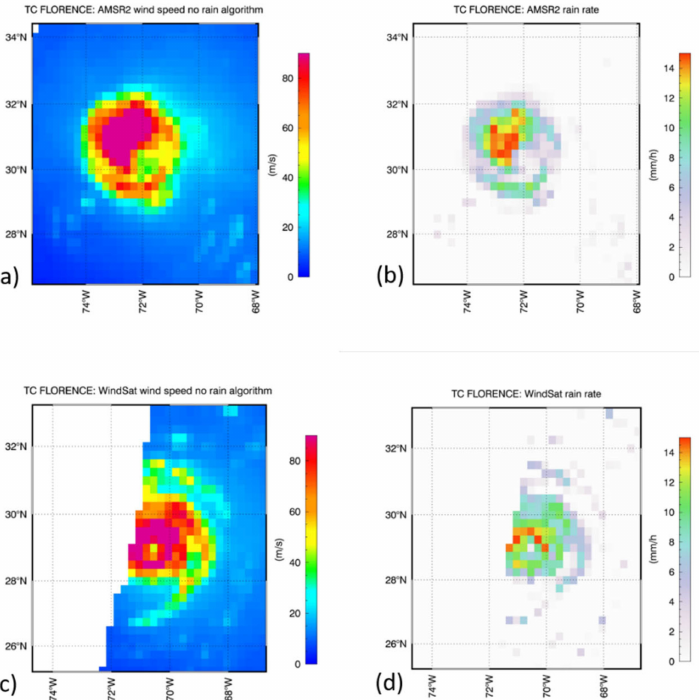
Figure 1. Passes of AMSR2 and WindSat over Hurricane Florence on 12 September 2018. The AMSR2 overpass occurred at 18:12 UTC. The WindSat overpass occurred at 10:54 UTC. ( a ) AMSR2 wind speed retrieved from the rain-free algorithm and displayed here even in rainy areas. ( b ) AMSR2 rain rate. ( c ) WindSat wind speed retrieved from the rain-free algorithm and displayed here even in rainy areas. ( d ) WindSat rain